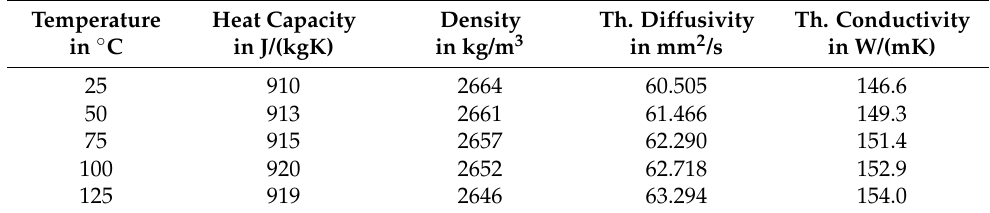
Table 3. Thermophysical properties of the aluminum